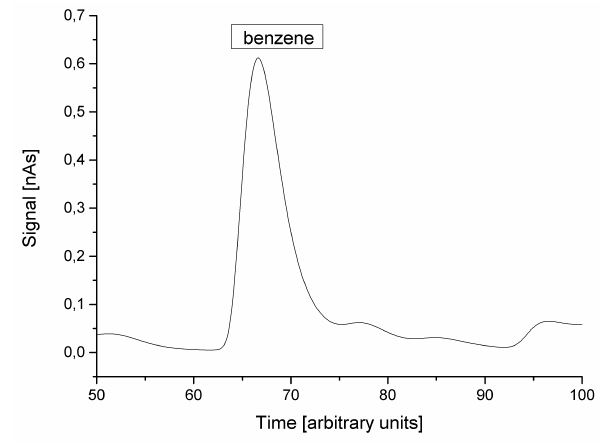
Fig. 9. Standard deviations of the δ 13 C values versus the mean peak areas for five peaks of different sizes, based on measurements of standard A; the error bars represent the uncertainties of the standard deviations (see text). Two power function-fits are applied to the data: with a free exponent (blue line) and with an exponent fixed to − 0 . 5 (red line, for details see text).